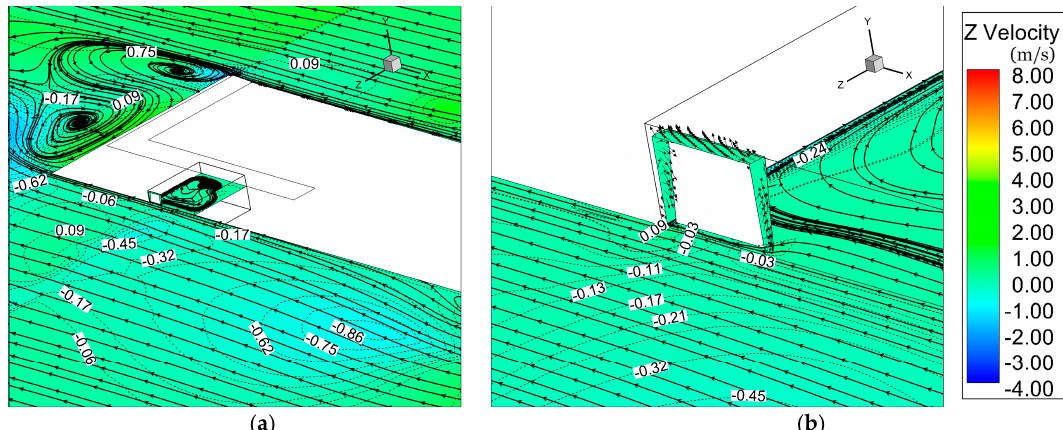
Figure 11. Flow patterns and contour of velocity (z-component), for 15m/s wind speed and wind direction of 45 o (a) around the building and (b) in front of the tilted window.